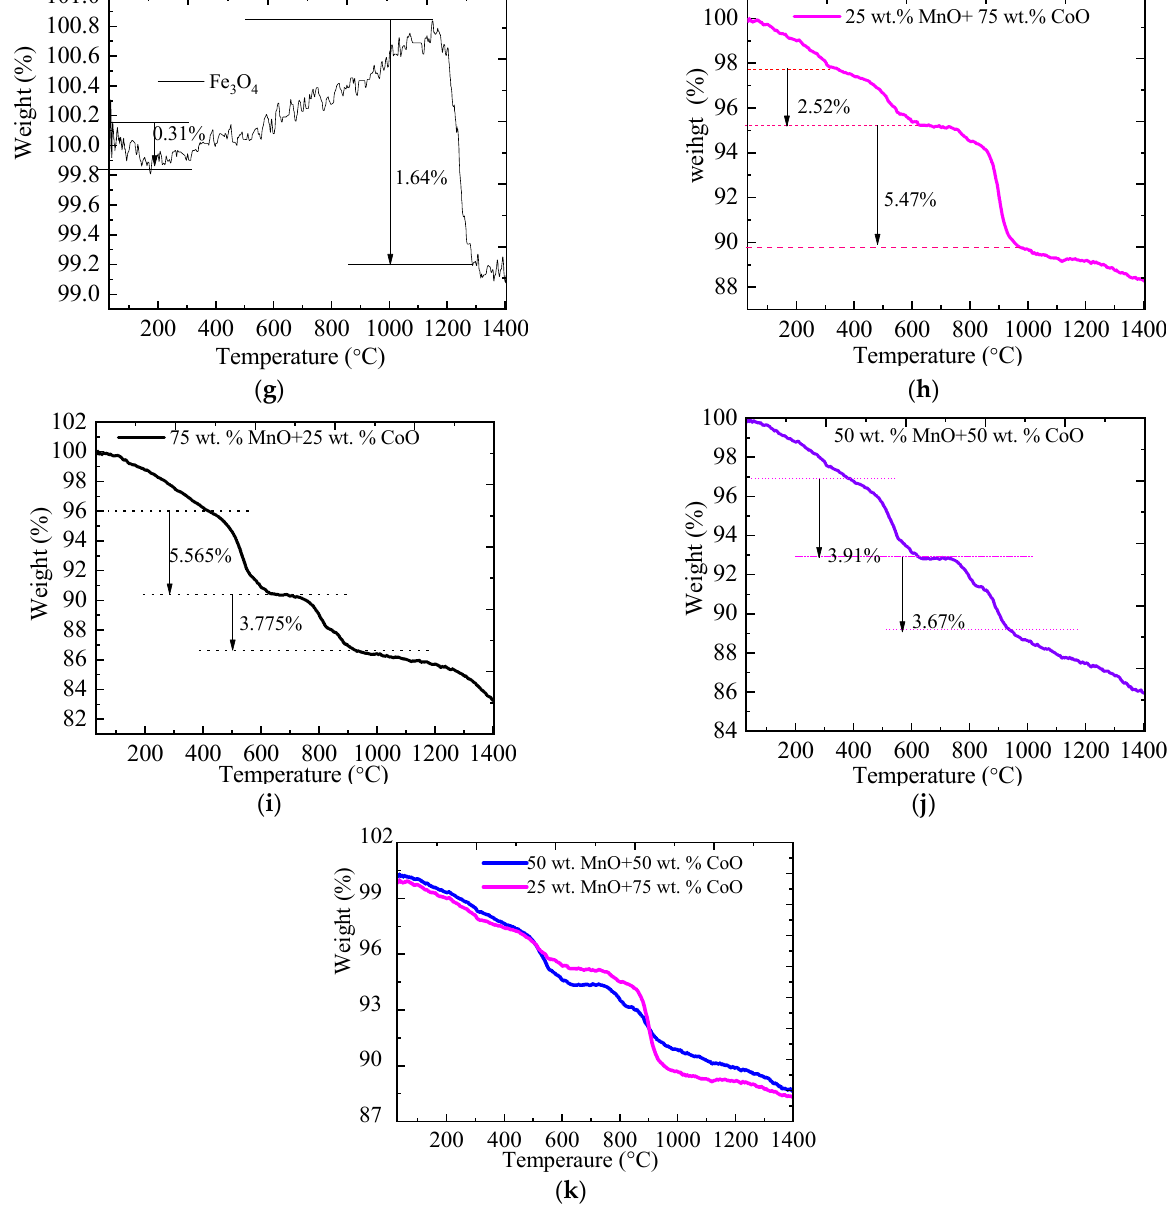
Figure 1. The TGA on mixed and pure metallic oxides at 30 mL Ar/min and 20 mL O 2 /min gas flow rates and 30 °C/min heating rate with applying temperature from room to 1400 °C and cooling to 800 °C for two step redox reaction: ( a ) TGA for two- step cyclic redox reaction for all oxides with time; ( b ) TGA for pure oxides with time; ( c ) TGA for mixed oxides that shows redox with time; ( d ) TGA for all oxides in the test with temperature in the first step of redox; ( e ) TGA for CoO with temperature in the first step of redox; ( f ) TGA for MnO with temperature in the first step of redox; ( g ) TGA for Fe 3 O 4 with temperature in the first step of redox; ( h ) TGA for 25 wt.% MnO + 75 wt.% CoO with temperature in the first step of redox; ( i ) TGA for 75 wt.% MnO + 25 wt.% CoO with temperature in the first step of redox; ( j ) TGA for 50 wt.% MnO + 50 wt.% CoO with temperature in the first step of redox; ( k ) TGA for 50 wt.% MnO + 50 wt.% CoO and 25 wt.% MnO + 75 wt.% CoO with tempertaure.